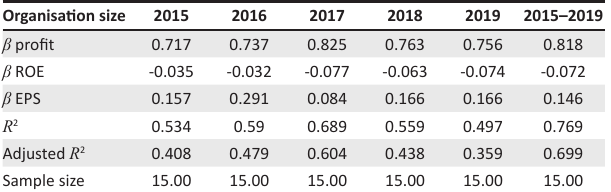
ROE, return on equity; EPS, earnings per